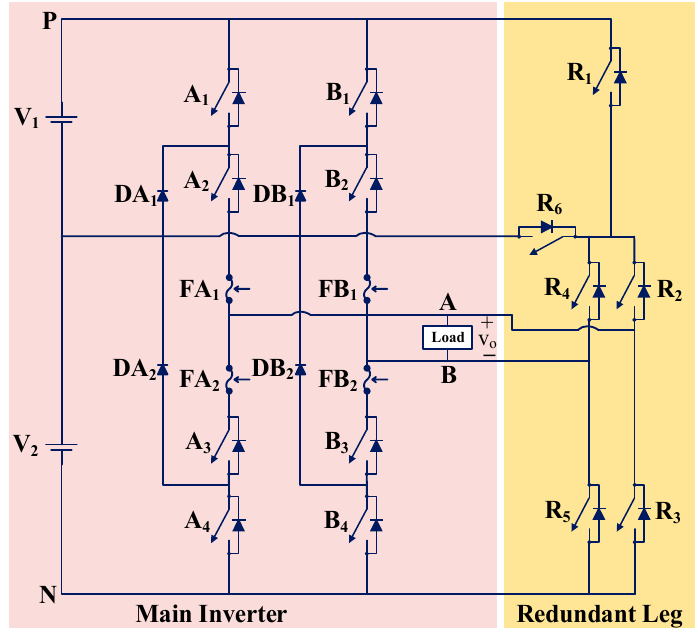
Figure 6. Single-phase five-level FT MLI (TP5) [34].